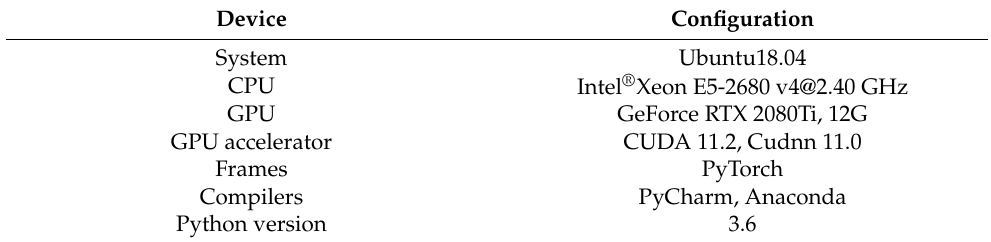
Table 2. Configuration parameters.